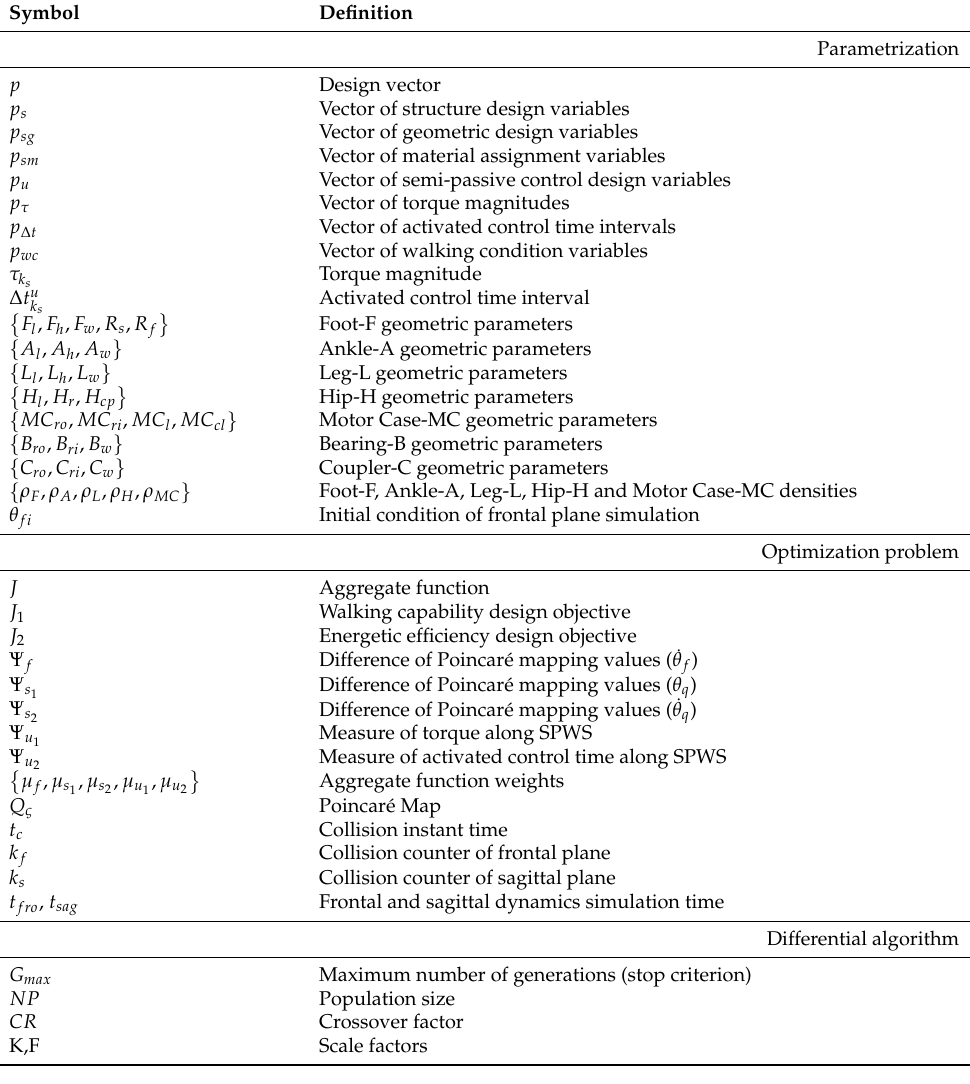
Table A2. Integrated S-C design problem